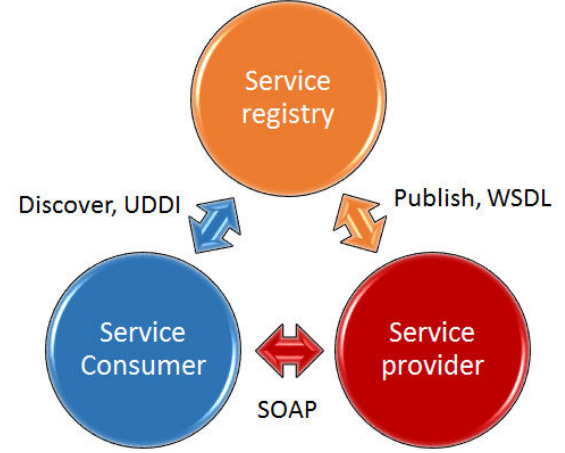
Figure 19. Web service architecture.